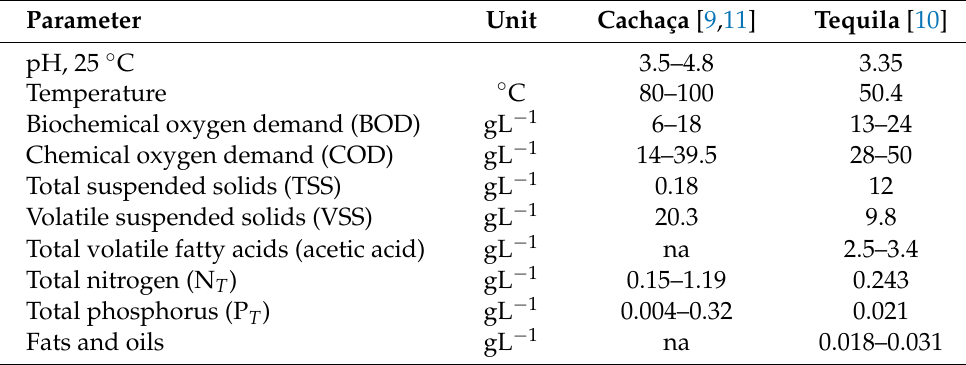
Table 1. Composition of the Cachaça and Tequila